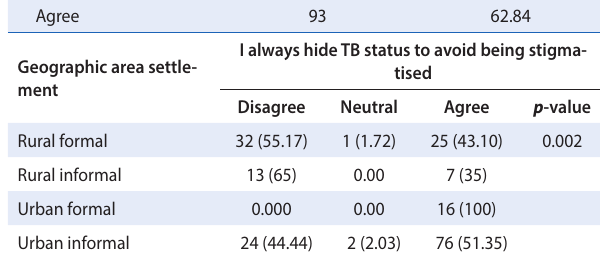
Figure 1a: Living arrangements.